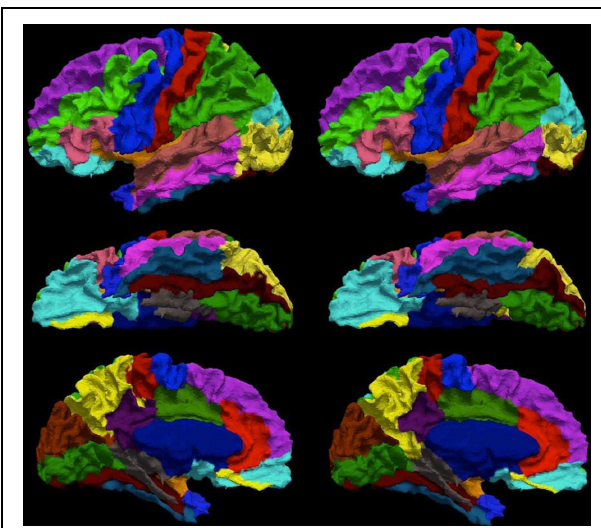
FIGURE 6 | The visual comparison of the manual (left column) and the automated (right column) parcellation for the subject shown in Figure3. The surface is parcellated into 24 sub-regions defined in Table 4 . The subject is chosen by having the median Dice coefficient. The surface is shown in a lateral (top row), ventral (central row), and medial (bottom row) view.